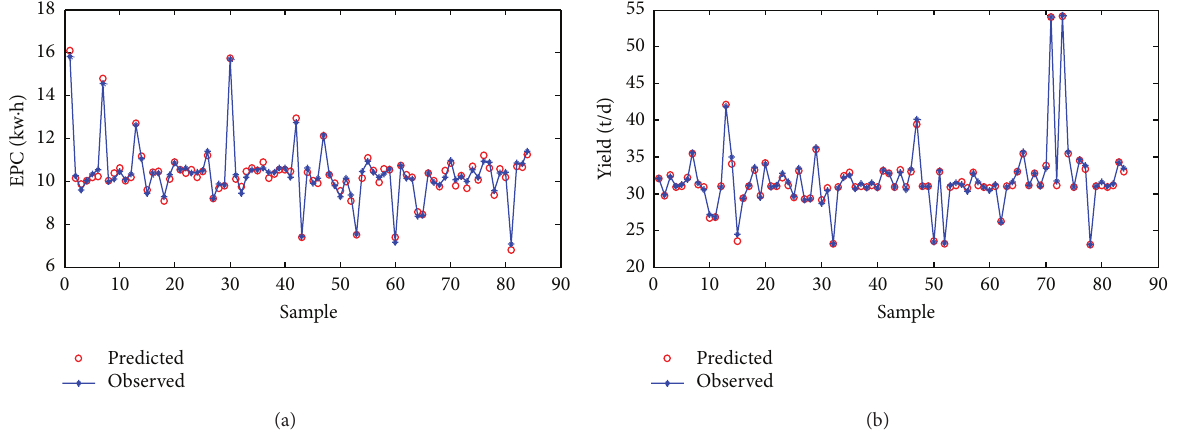
Figure 4: Comparison of the predicted and real objectives of GRNN model. (a) EPC and (b) OY.